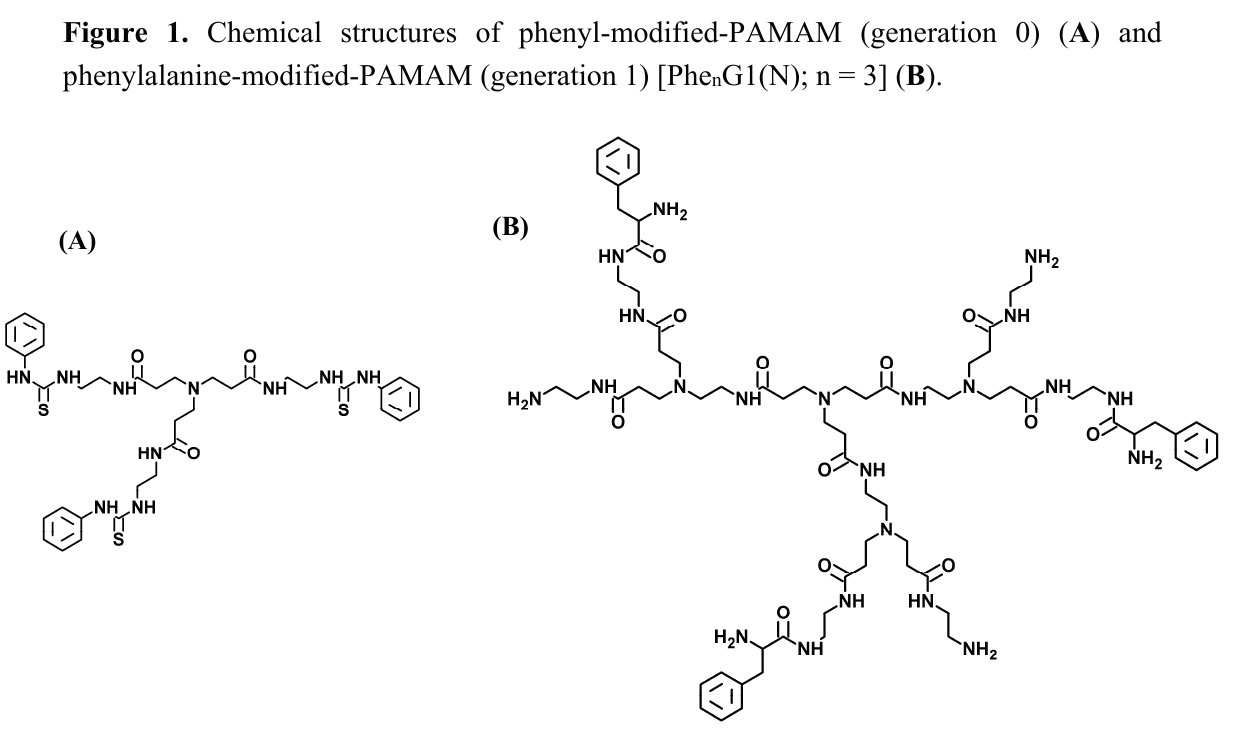
Figure 1. Chemical structures of phenyl-modified-PAMAM (generation 0) ( A )